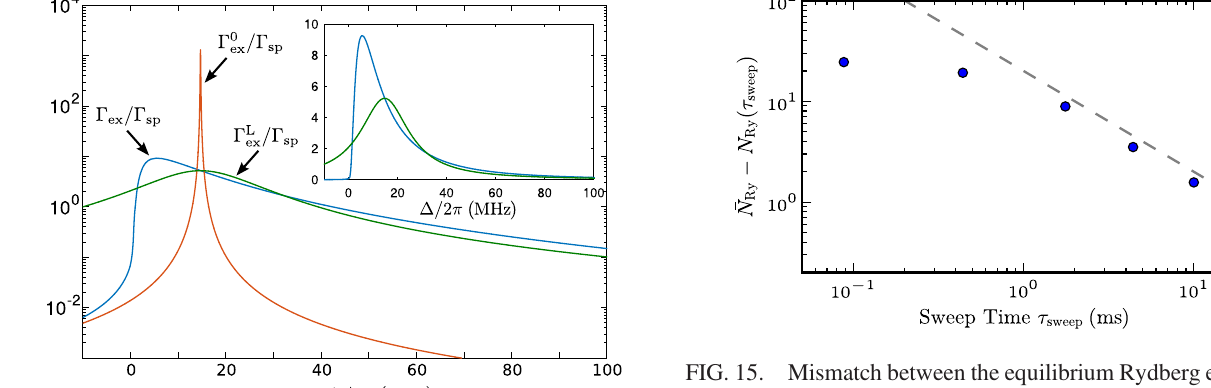
τ after Ry ð sweep Þ sweep